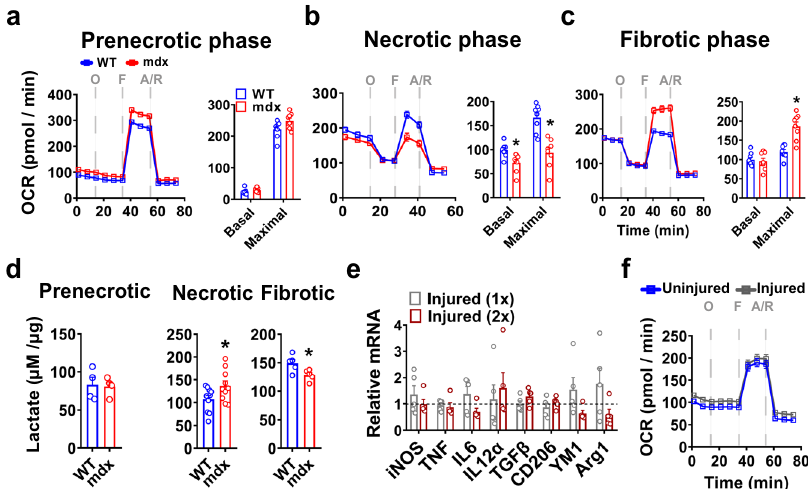
Fig. 2 Metabolic changes in mdx BMDM at different disease stages. a – c Oxygen consumption rate (OCR) values after sequential treatment of BMDM with oligomycin (O), FCCP (F) and antimycin + rotenone (A/R) as measured by the Seahorse XF Analyzer at: a prenecrotic ( n = 8/group), b necrotic ( n = 8/group), and c fi brotic ( n = 8/group) phases of disease. OCR values are normalized to cell count. d Lactate levels (normalized to µ g of cell lysate protein) in supernatants from WT and mdx BMDM after incubating the cells for 48 h in phenol-red-free RPMI culture media ( n = 4/group for prenecrotic, n = 10/group for necrotic, and n = 5/group for fi brotic). e mRNA transcript levels in BMDM (expressed relative to the mean uninjured level represented by the dashed line) obtained from WT mice after acute muscle injury (Injury 1x = injection of cardiotoxin into both tibialis anterior muscles with euthanasia 3 days later; Injury 2x = injection of cardiotoxin into tibialis anterior and gastrocnemius muscles on days 0 and 3, respectively, with euthanasia at day 13) ( n = 5/group). f Representative OCR curve from Injury 1x group in e ( n = 5/group). Data represent means± SEM of biologically independent samples from different mice. * P < 0.05 vs. WT (unpaired t -test, two-tailed). See Source Data fi le for the exact P -values.